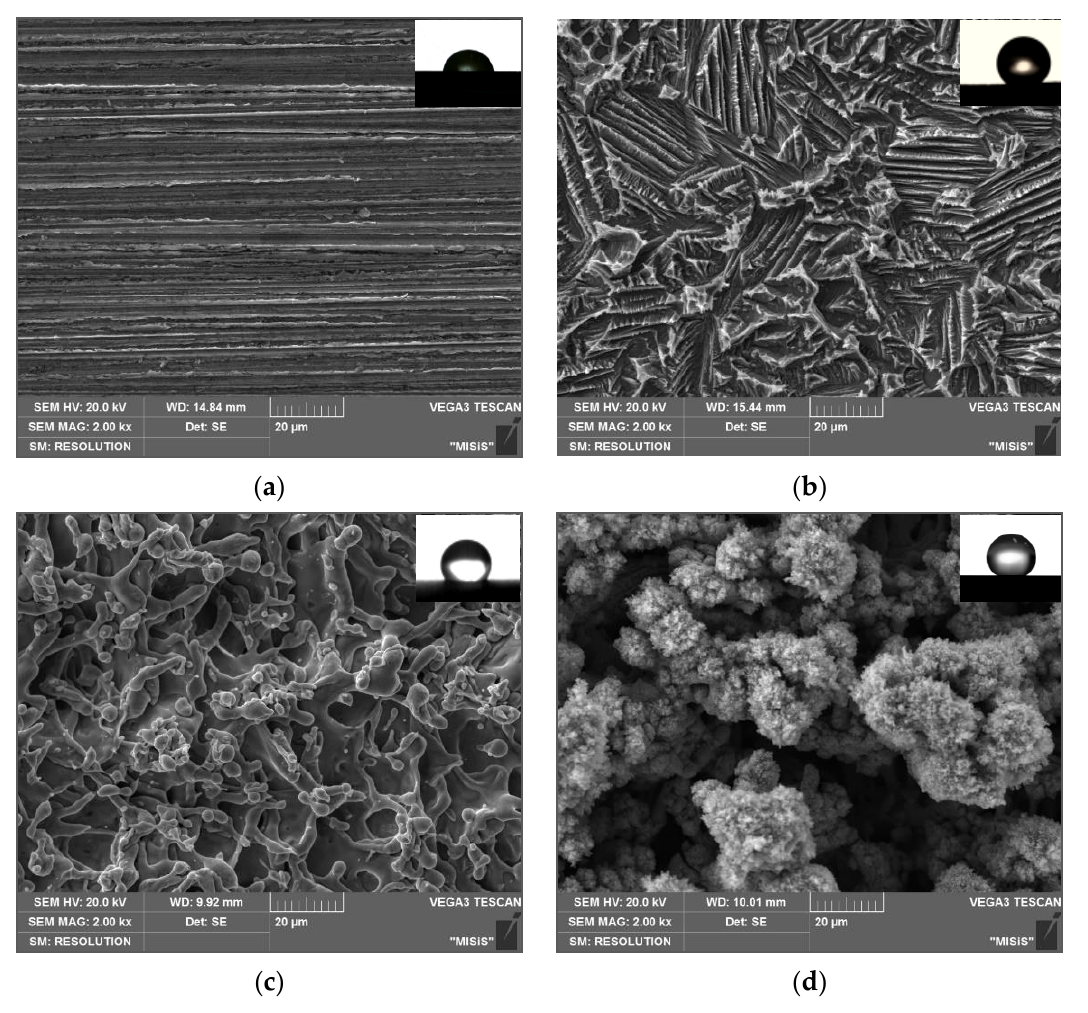
Figure 2. SEM images of ( a ) “smooth” zinc surface (Type 1) and after texturing by ( b ) chemical etching (Type 2) and laser with ( c ) V = 700 mm/s (Type 3) and ( d ) 100 mm/s (Type 4).